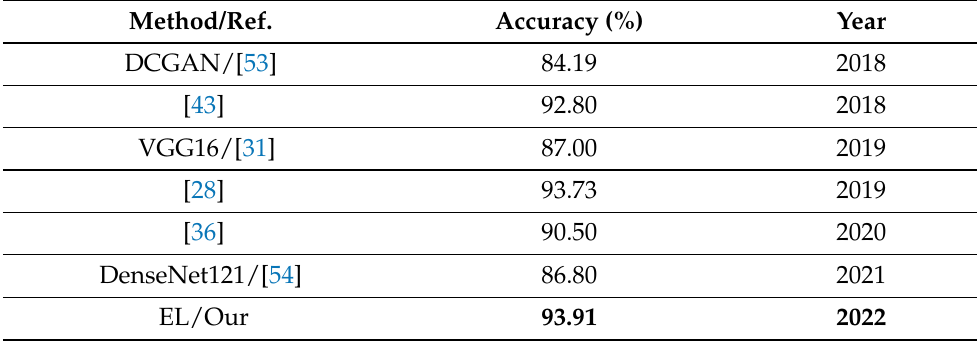
Table 3. Comparative accuracy results for the state-of-the-art method on test set of the chest X-ray data set. The best results for each item are labeled in